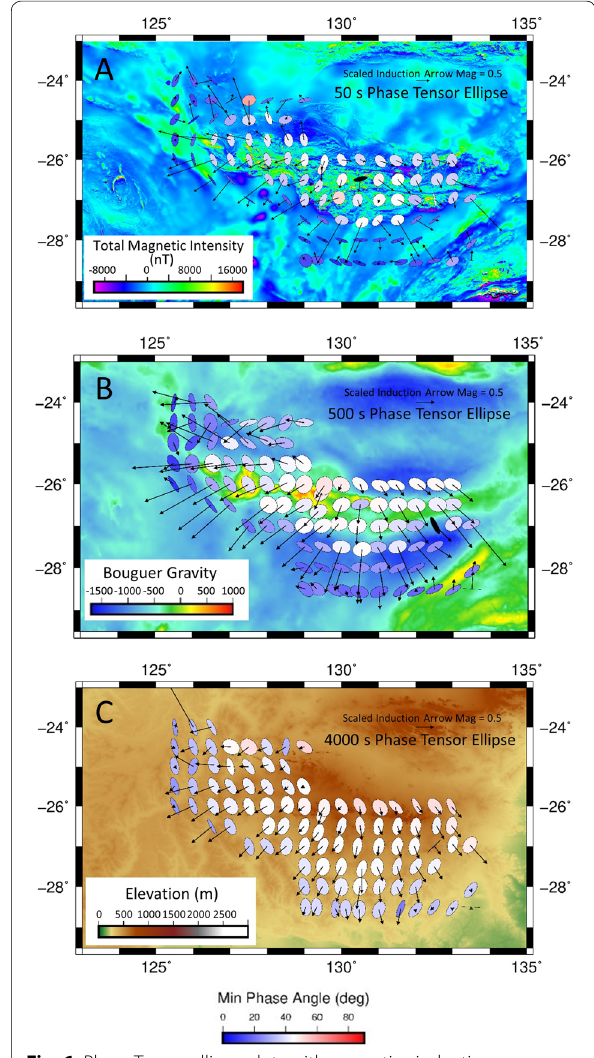
Fig. 6 Phase Tensor ellipse plots with respective induction arrow at a 50 s, b 500 s and c 4000 s, each with overlain respective period induction arrows to show both the aerial and depth variation of the Musgrave MT Data. a A total magnetic intensity background image, b a Bouguer gravity image and c an elevation